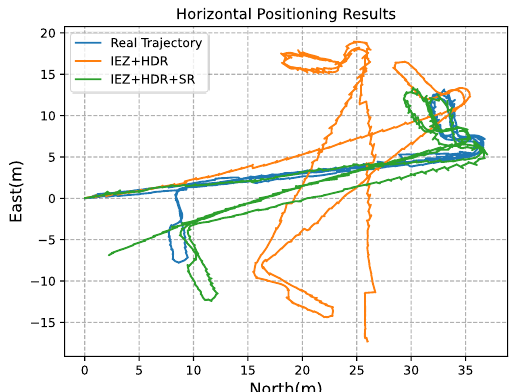
Figure 10 . Horizontal positioning results (Experiment 2).